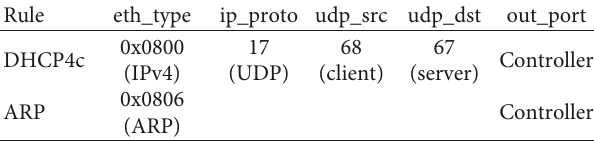
Table 1: IPv4 address resolution service rules.